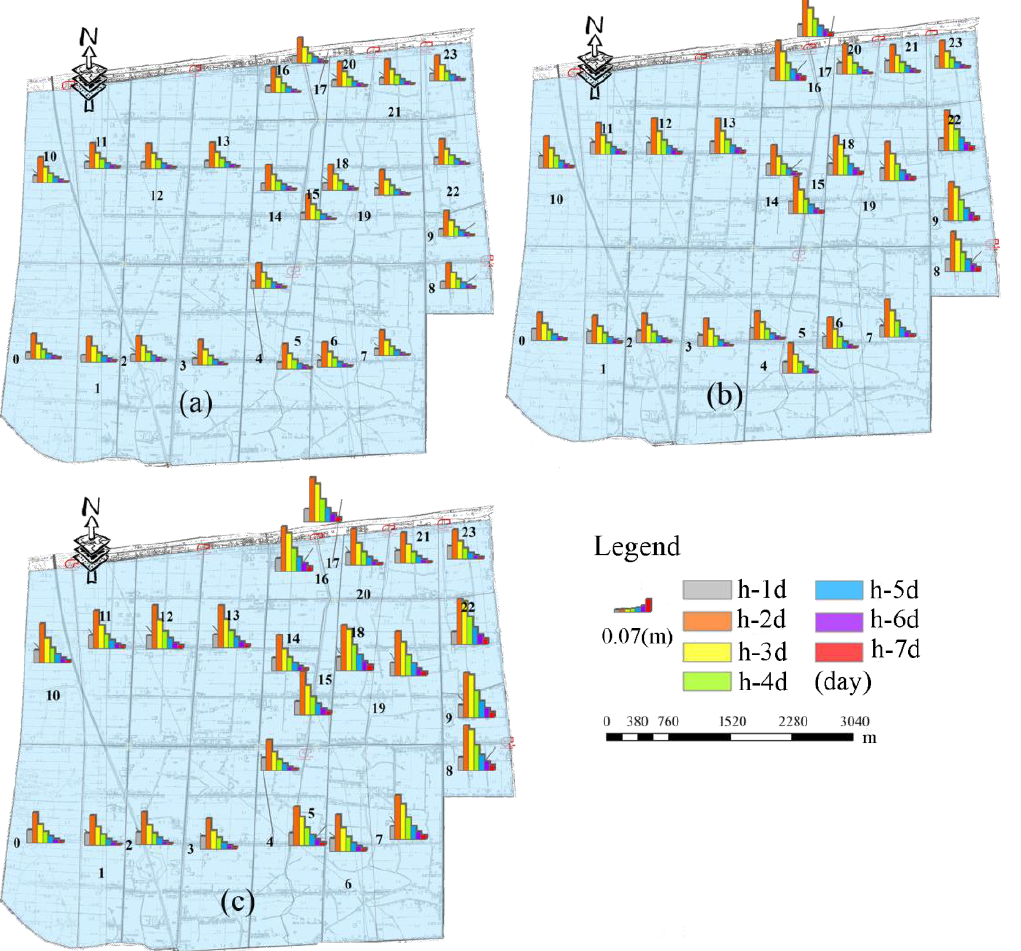
Figure 5. Variation and distribution of submerged depth under different rainfall return periods of the current scenario (( a ). P5% ( b ). P2% ( c ). P1%, unit: m).